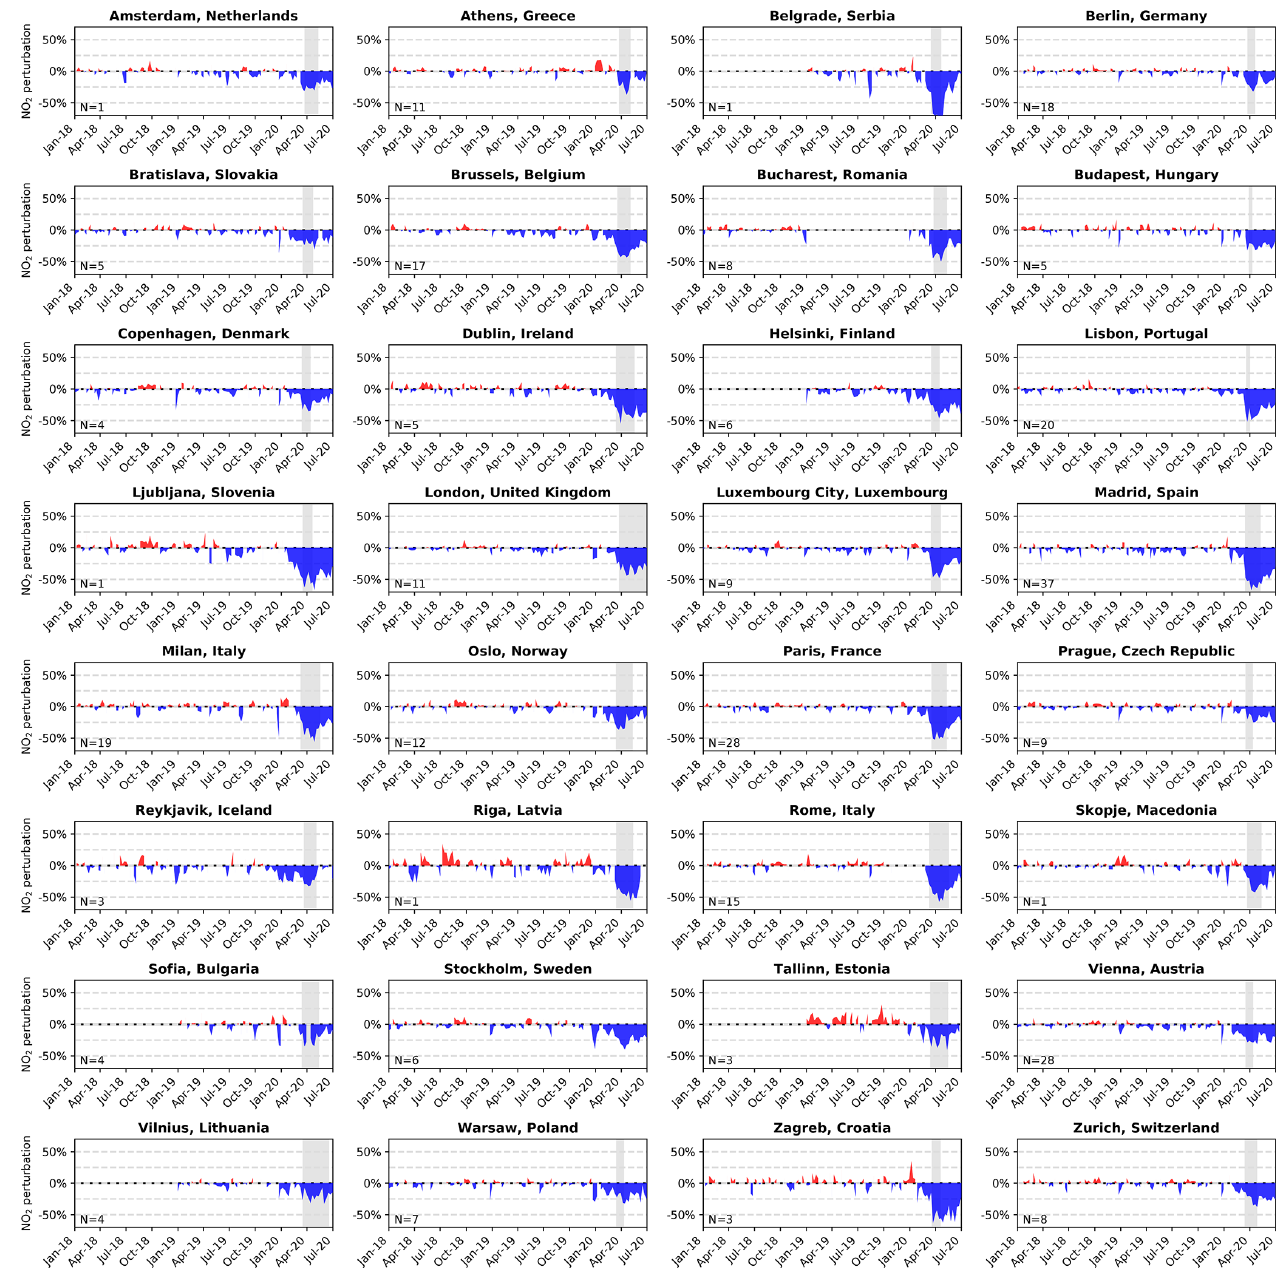
Figure A7. The same as Fig. A6 but for